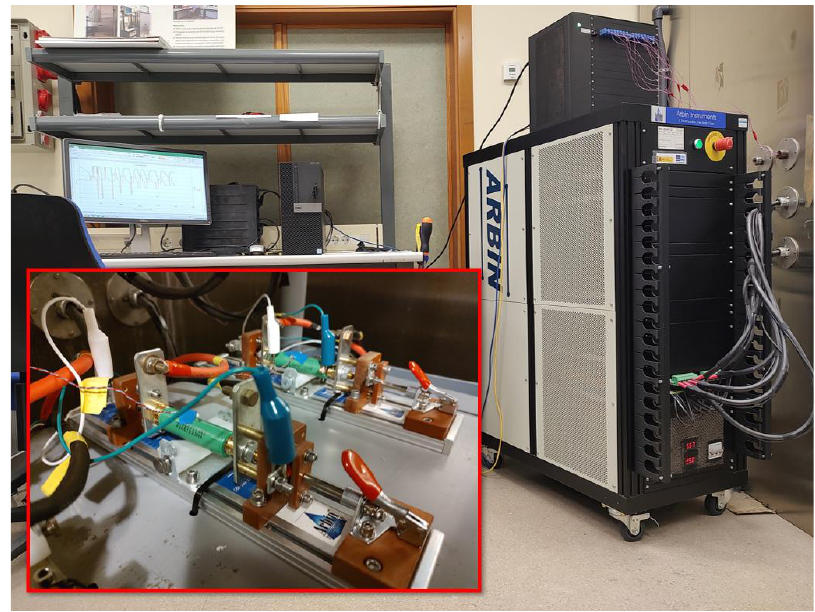
Figure 1. Photographs of the test equipment and some cells under test.